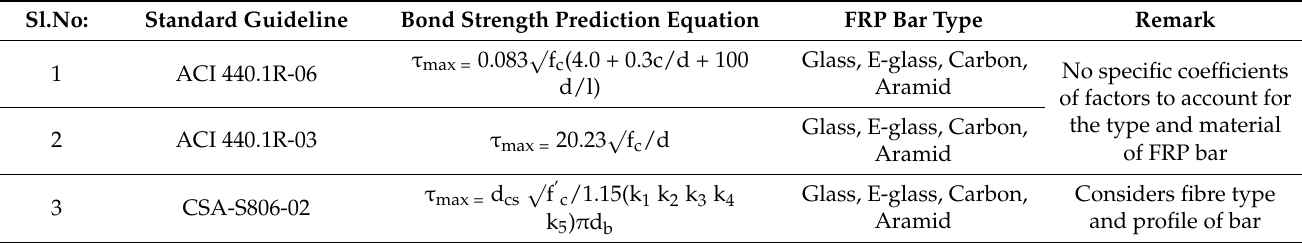
Table 5. Bond strength prediction equation for FRP bars in